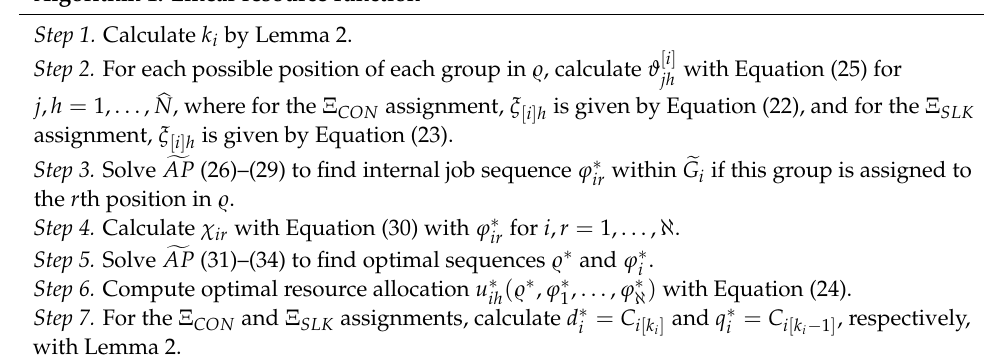
Algorithm 1: Linear resource